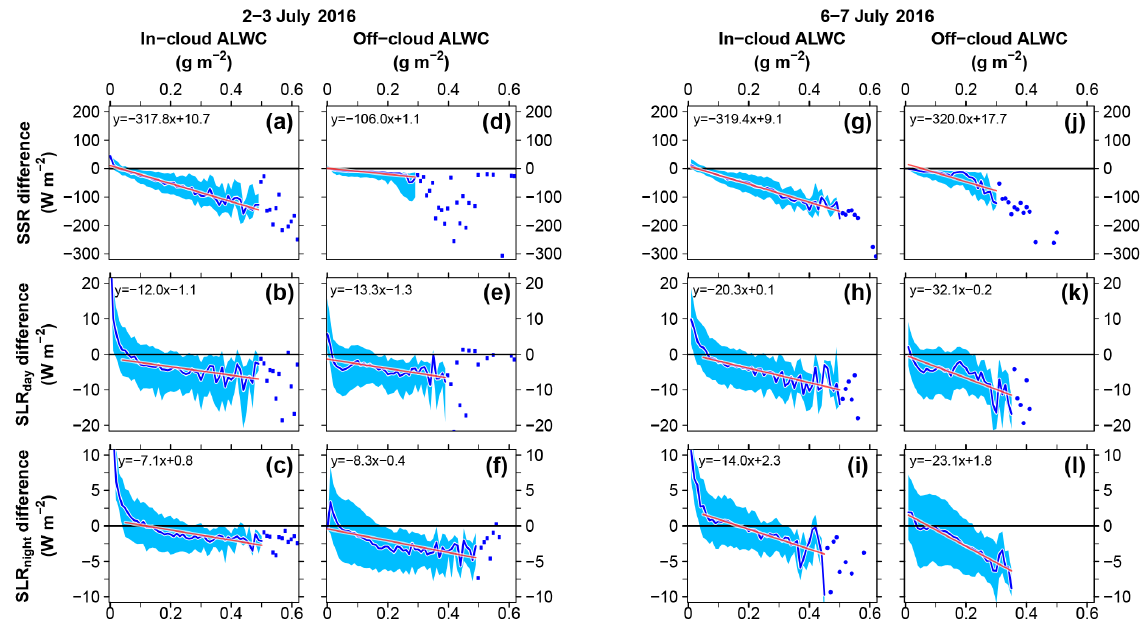
Figure 14. Relationship between the total column ALWC (gm − 2 ) and the radiation difference between the reference and No-ALWC (Wm − 2 ) capturing the Ivory Coast (7.5–3 ◦ W, 4–8 ◦ N) and the time period (two left columns) 2–3 July and (two right columns) 6–7 July. The data are clustered in areas that are simultaneously cloudy (in-cloud ALWC) or cloud free (off-cloud ALWC) in both realizations. The top panels show the daytime SSR difference: (a, d) 2 July 15:00–18:00UTC and 3 July 07:00–15:00UTC; (g, j) 6 July 15:00–18:00UTC and 7 July 07:00–15:00UTC. The middle panels show the SLR daytime difference (same time period as SSR) and the bottom panels present the nighttime SLR difference: (c, f) 2 July 19:00UTC to 3 July 06:00UTC; (i, l) 6 July 19:00UTC to 7 July 06:00UTC. The ALWC values are clustered in bins with an increment of 0.01gm − 2 . For every bin the spatial median of the radiation difference is calculated (blue line). The envelope, spanned by the 25th and 75th percentile of the radiation difference, is shown as blue shading. For greater ALWC values the spread significantly increases. For this area (empirically selected) the median radiation difference is shown as blue dots instead of a blue line. A linear fit is calculated for the first part of the curves (red line). The fitted equations are shown in the top left corner of the